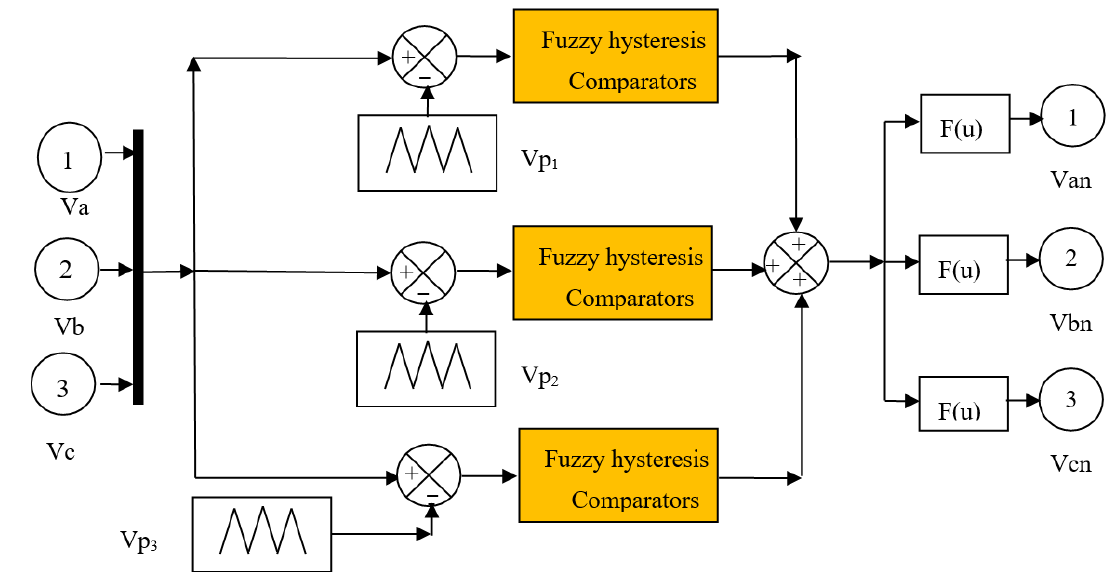
Figure 4. Traditional hysteresis controllers.